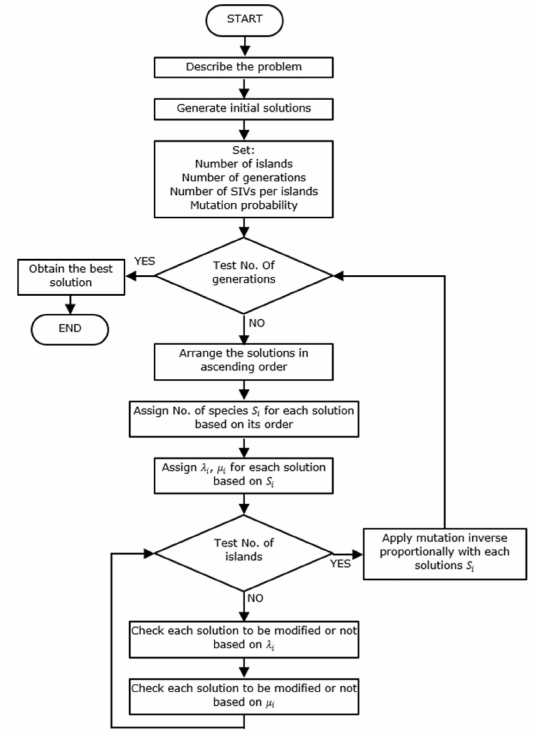
Figure 6. Biogeography-Based Optimization